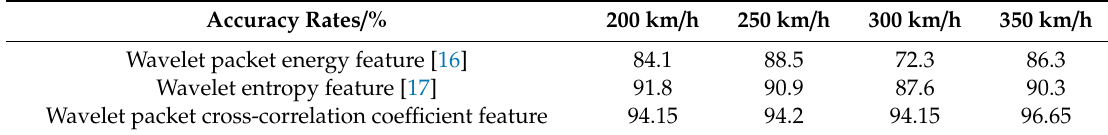
Table 8. Comparison of recognition rates of different feature extraction methods